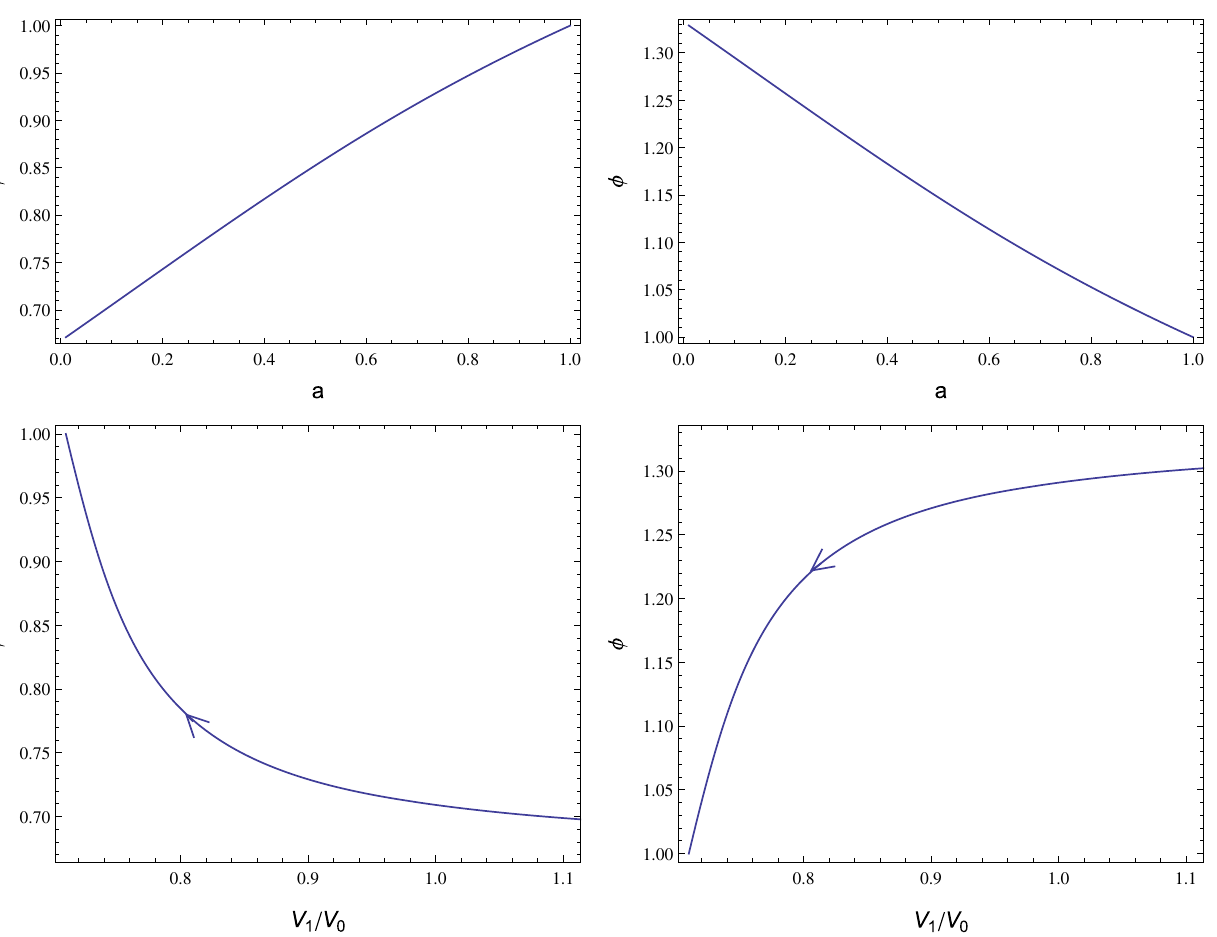
Fig. 1 The upper left and lower left panels corresponding to a plus sign in Eq. (22) represent the relation between the quintessence field φ and the scale factor a , and the relation between the quintessence field φ and the potential V 1 / V 0 . The upper right and lower right panels corre- sponding to a minus sign in Eq. (22) represent the relation between the